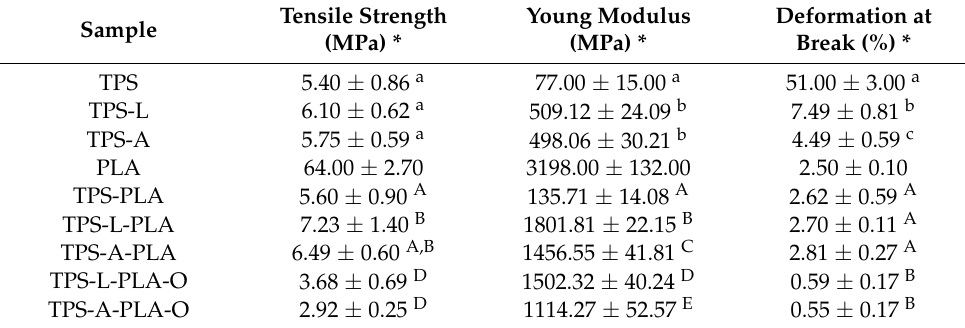
Table 2. Tensile properties in the TPS, PLA and the blends of TPS-PLA.